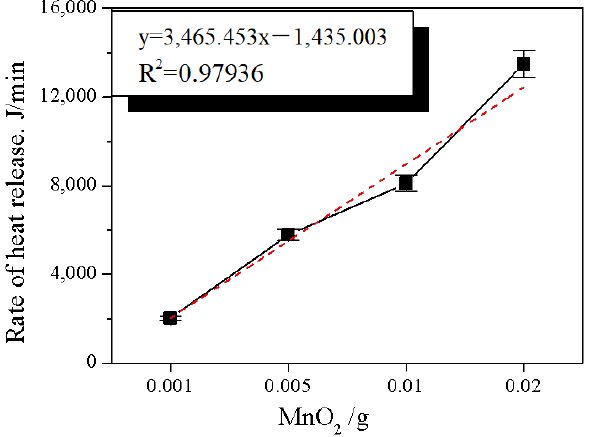
Figure 2. Effect of manganese dioxide on the exothermic rate.